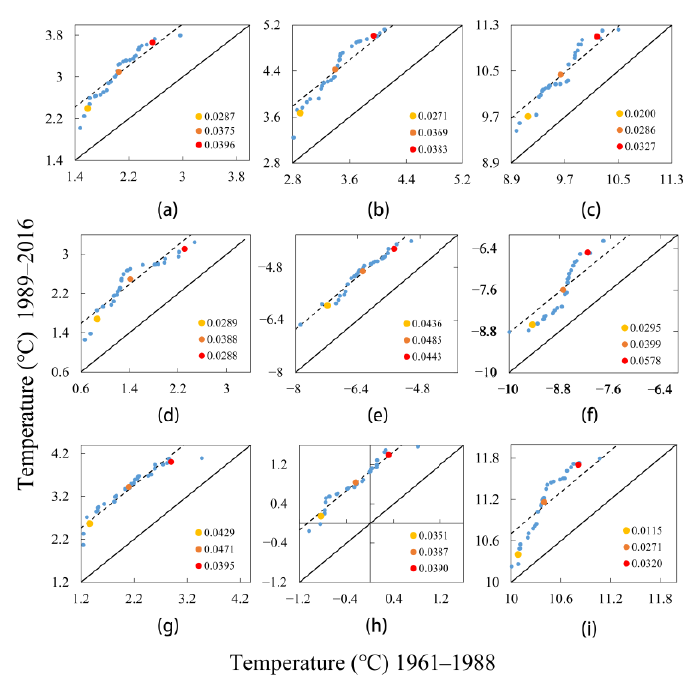
Figure 5. Results of innovative trend analysis (ITA) for the minimum temperature over the whole JRB: ( a ) annual, ( b ) spring, ( c ) summer, ( d ) autumn, ( e ) winter. Annual minimum temperature in the sub-basins ( f ) SRJRB, ( g ) UPJRB, ( h ) YLRB, and ( i ) MLJRB. Yellow, orange, and red points denote the mean central points of the low, medium, and high categories, respectively.